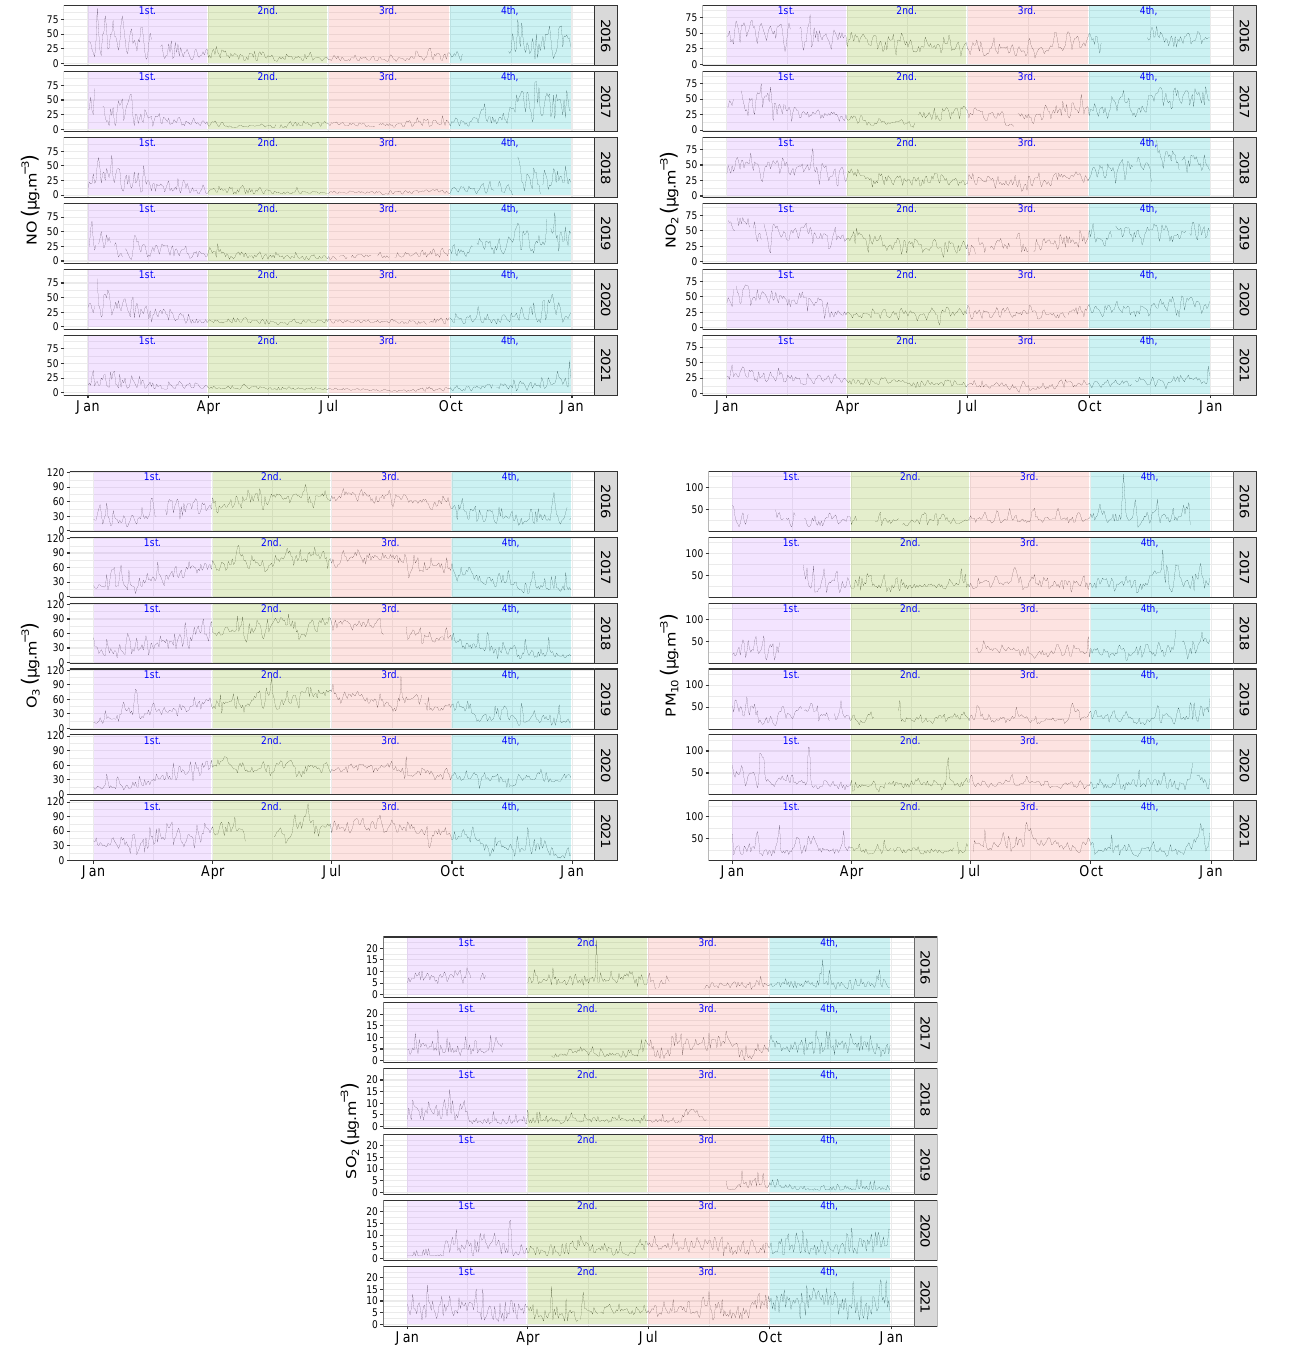
Figure 5. Evolution of the daily concentrations of NO, NO 2 , O 3 , PM 10 , and SO 2 at the San Basilio